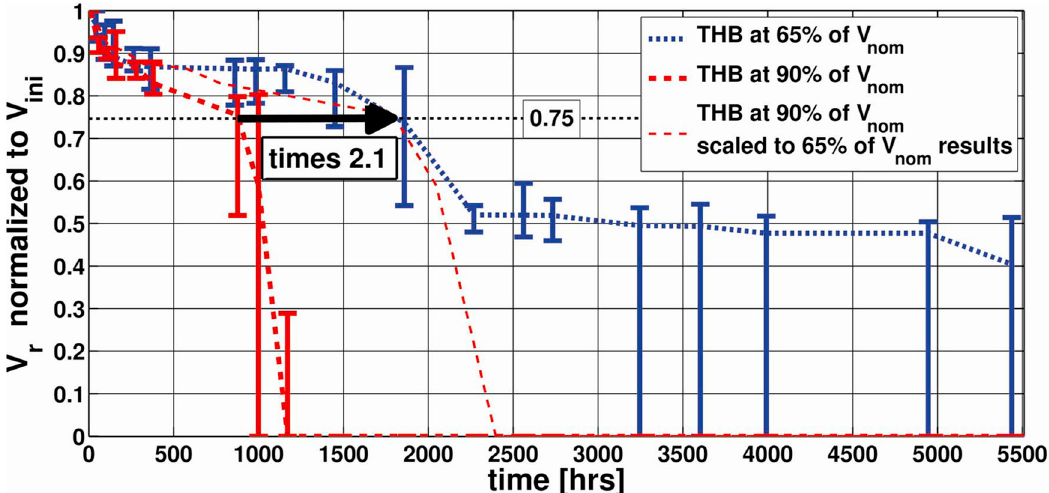
Figure 5. The effect of acceleration due to bias voltage with respect to the initial breakdown voltage (BV) values versus test time. Figure reproduced with permission from [9].